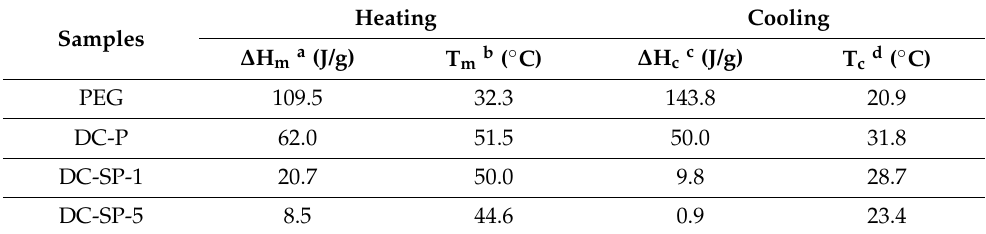
Table 3. Thermal properties of PEG and modified